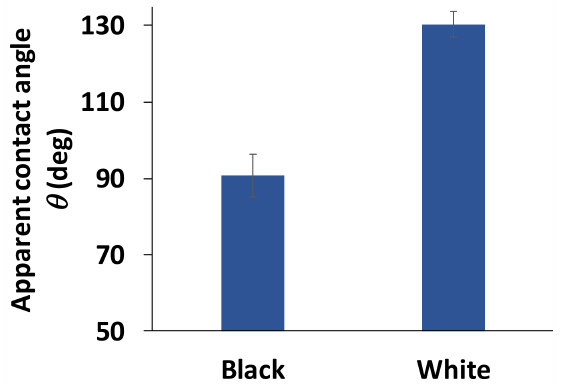
Figure 2. Wettability measurements on the black and white parts of the G. orientalis elytra. The graph represents mean ± standard